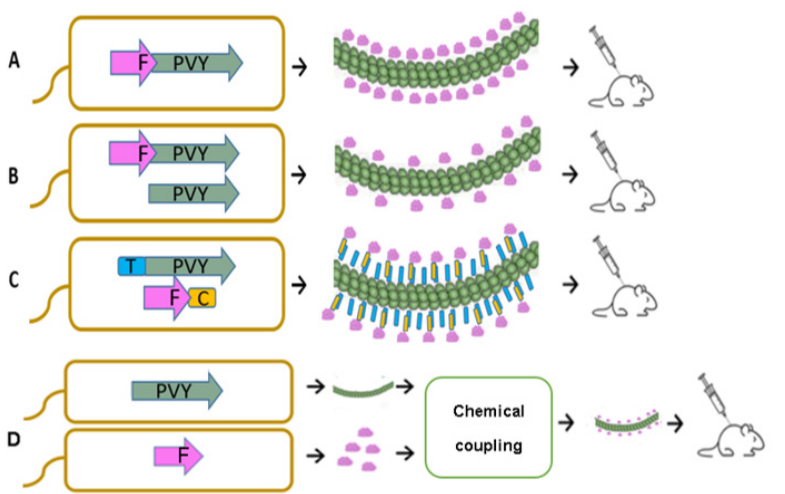
Figure 1. Principal schemes of vaccine production processes using E. coli expression systems; ( A )—direct antigen fusion to the coat protein (CP) of filamentous PVY VLPs; ( B )—coexpression of antigen-containing PVY CP and unmodified PVY CP for the production of mosaic VLPs; ( C )—coexpression of vaccine components, allowing the formation of VLP–antigen conjugates directly in E. coli cells. F–Feld1 protein; ( D )—chemical coupling of PVY VLPs and Fel d 1 protein. PVY–PVY coat protein; T—SpyTag; C—SpyCatcher.